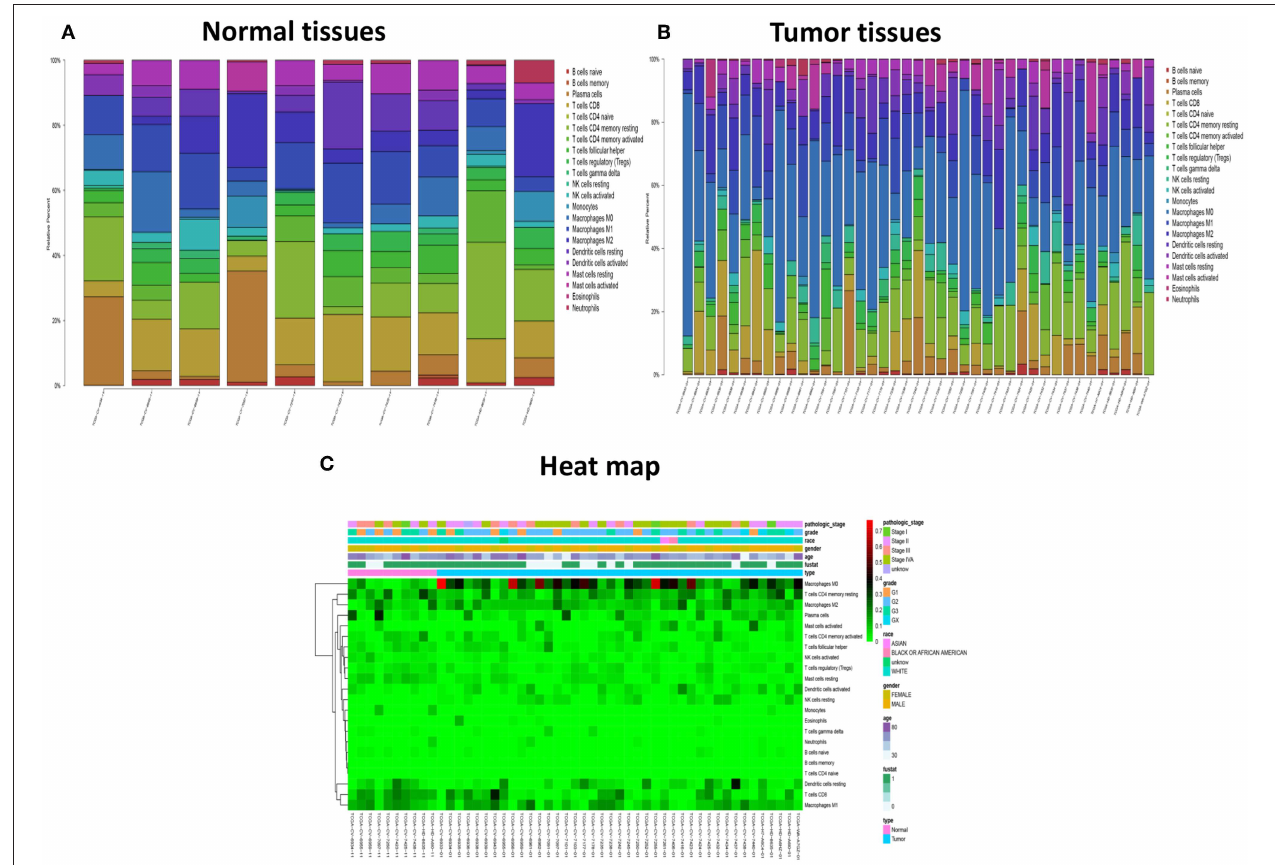
FIGURE 1 | The performance of CIBERSOST for estimating TIICs composition in HNC. (A) Relative proportions of 22 TIICs subpopulation in normal samples. (B) Relative proportions of 22 TIICs subpopulation in tumor samples. (C) Heat map of the 22 immune cell